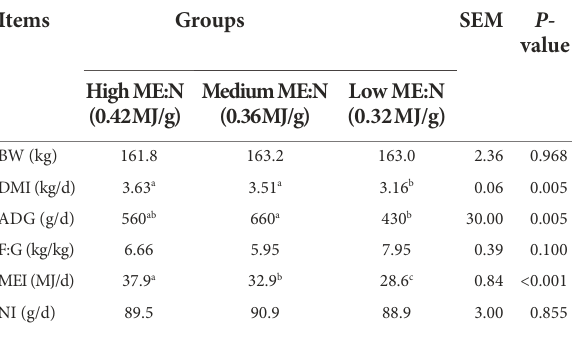
TABLE 2 Effect of dietary ME:N ratio on dry matter intake, average daily gain, and feed:gain ratio in yaks. Items